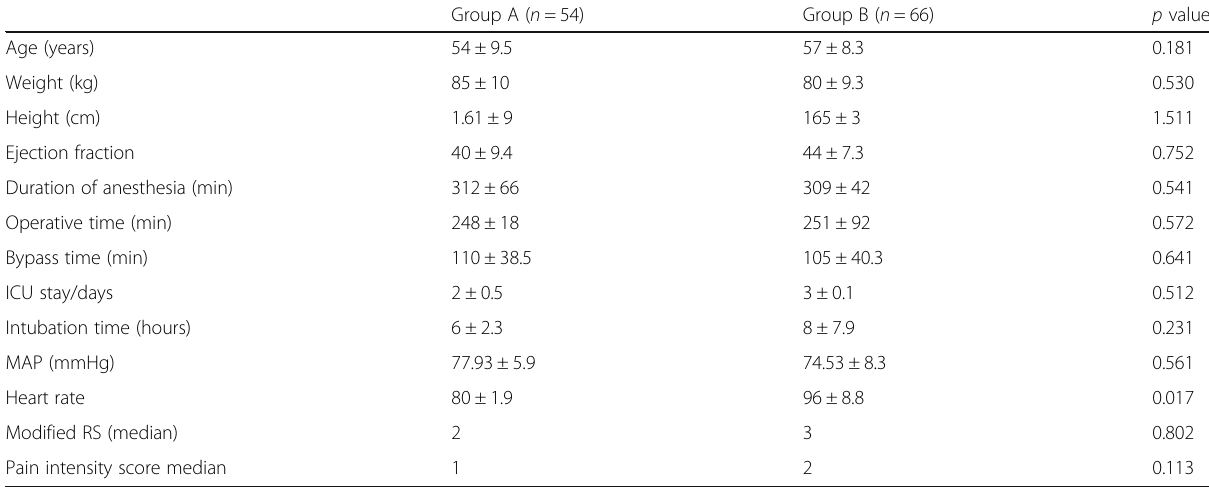
Table 1 Comparison of the preoperative, operative, and postoperative data between groups (continuous data are presented as mean and standard deviation or median and categorical data as number and